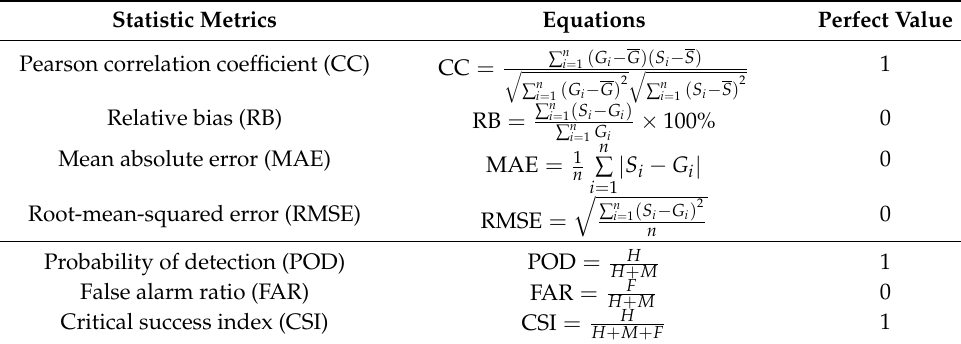
Table 2. List of the statistical metrics used in this study. Statistic Metrics Equations Perfect Value Pearson correlation coefficient